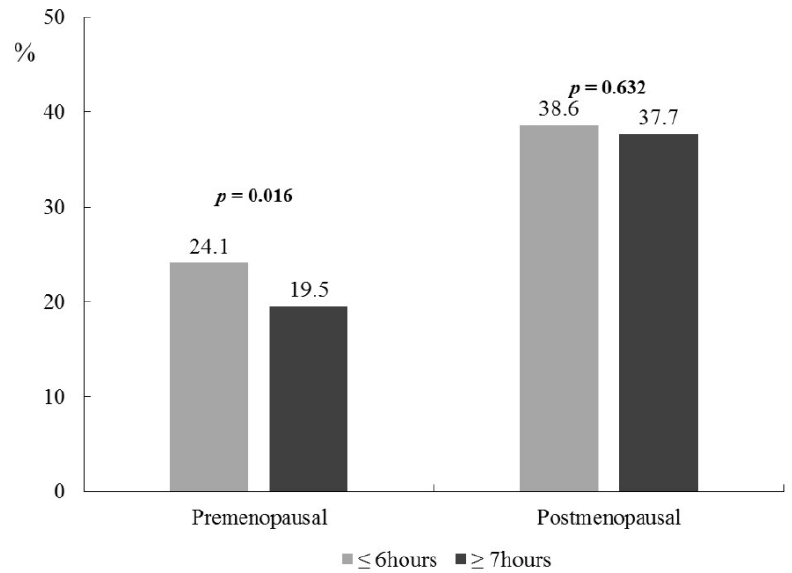
Figure 2. Prevalence of obesity and metabolic syndrome by sleep duration in participating Korean women. Premenopausal, n = 2906 for ≤ 6 h, n = 6308 for ≥ 7 h. Postmenopausal, n = 4297 for ≤ 6 h, n = 4276 for ≥ 7 h. p -values were calculated using a general linear model test after adjustment for age, education level, monthly household income, hypertension, cardiovascular disease, diabetes, smoking status, alcohol drinking, and physical activity